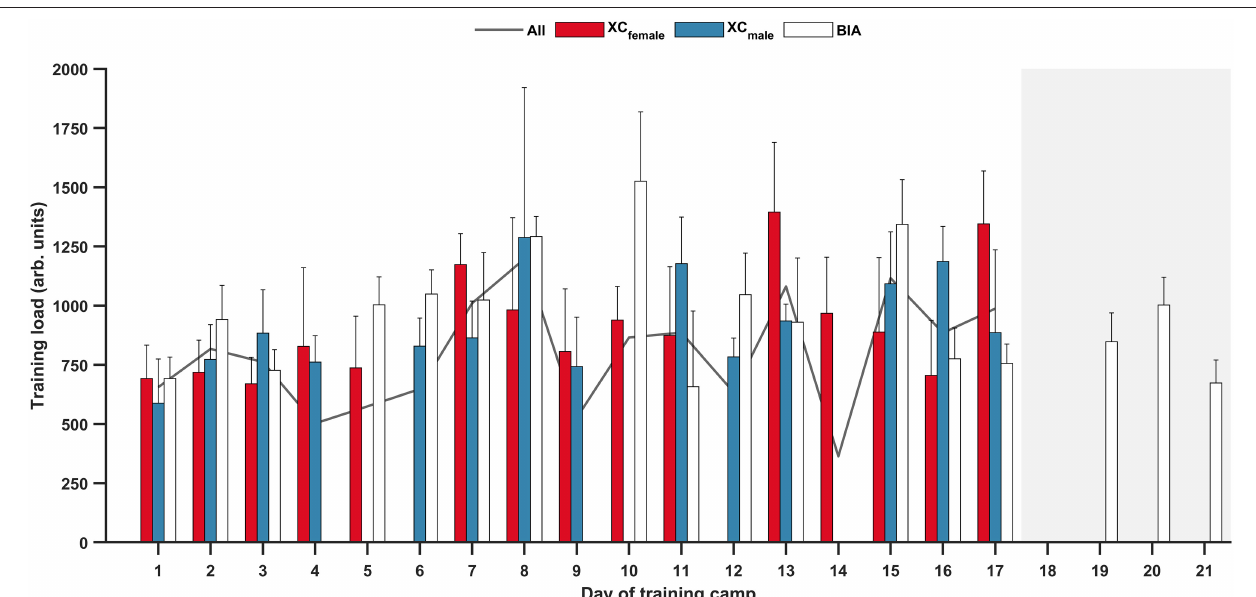
FIGURE 2 | Daily training load (mean ± SD) for female cross-country skiers (XC female ); male cross-country skiers (XC male ); biathletes (BIA); and all athletes (All, mean only) during the training camp. Shaded area indicates biathletes